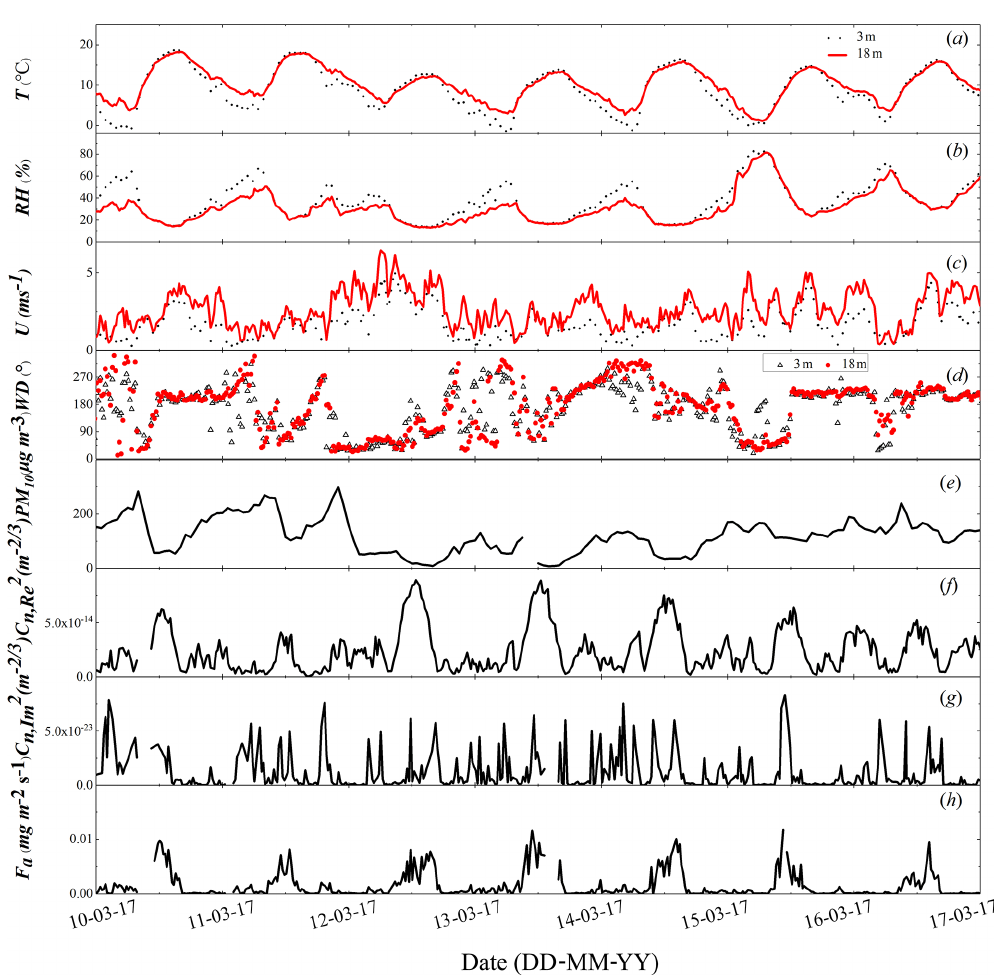
Figure 4. Temporal variations in (a) air temperature, (b) RH, (c) wind speed, (d) wind direction, (e) PM 10 , (f) real part of the AERISP, (g) imaginary part of the AERISP, and (h) aerosol mass flux in the Baoding area from 10 to 17 March